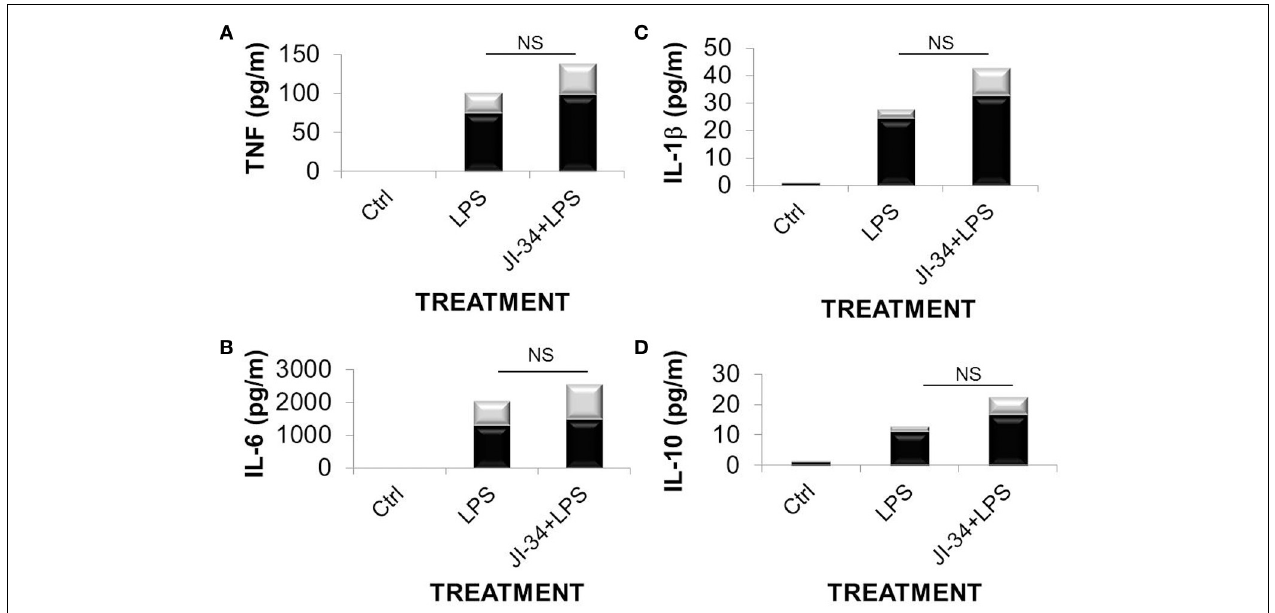
FIGURE 3 | Concentrations of (A) TNF; (B) IL-6; (C) IL-1 β ; and (D) IL-10 in BALF from vehicle-treated, LPS-treated (0.65mg/kg) or JI-34 (100 μ g/kg) + LPS treated mice ( n = 4 per group) in pg/ml,